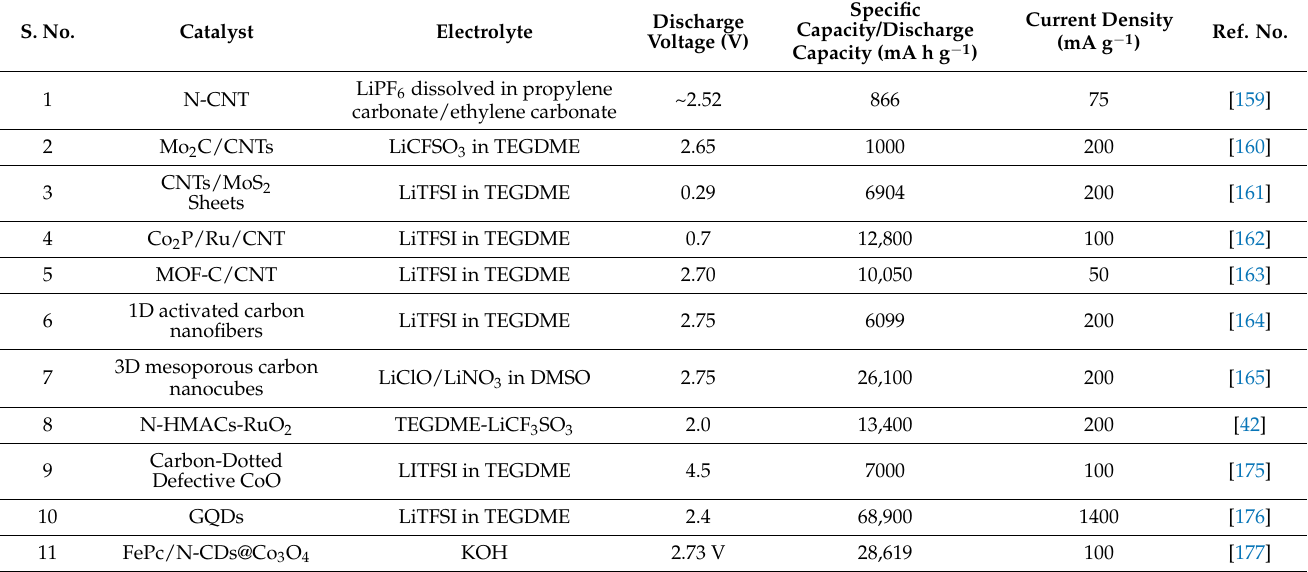
Table 4. Comparison of the cell performances of various other carbon nanomaterials such as CNTs, CNFs, GQDs and its composite